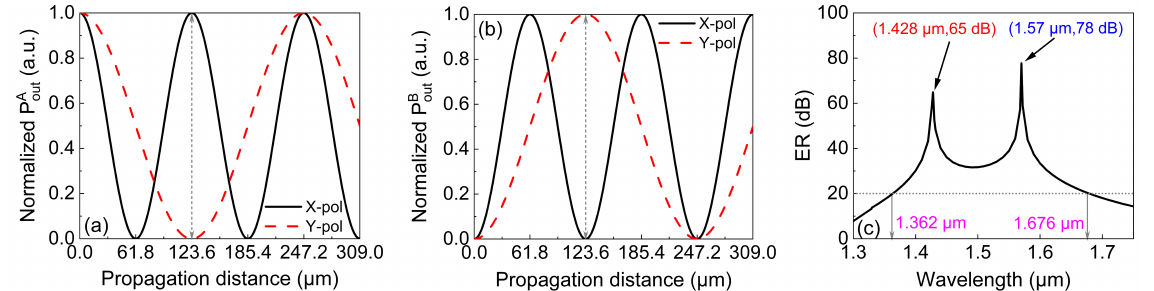
Figure 10. The relationship between the normalized output power and propagation distance in ( a ) core A and ( b ) in core B, and ( c ) the ER in core A between 1.3 and 1.75 µ m with the optimized structural parameters. Table 2. Comparison of the PBS performance between this work and other reported work.